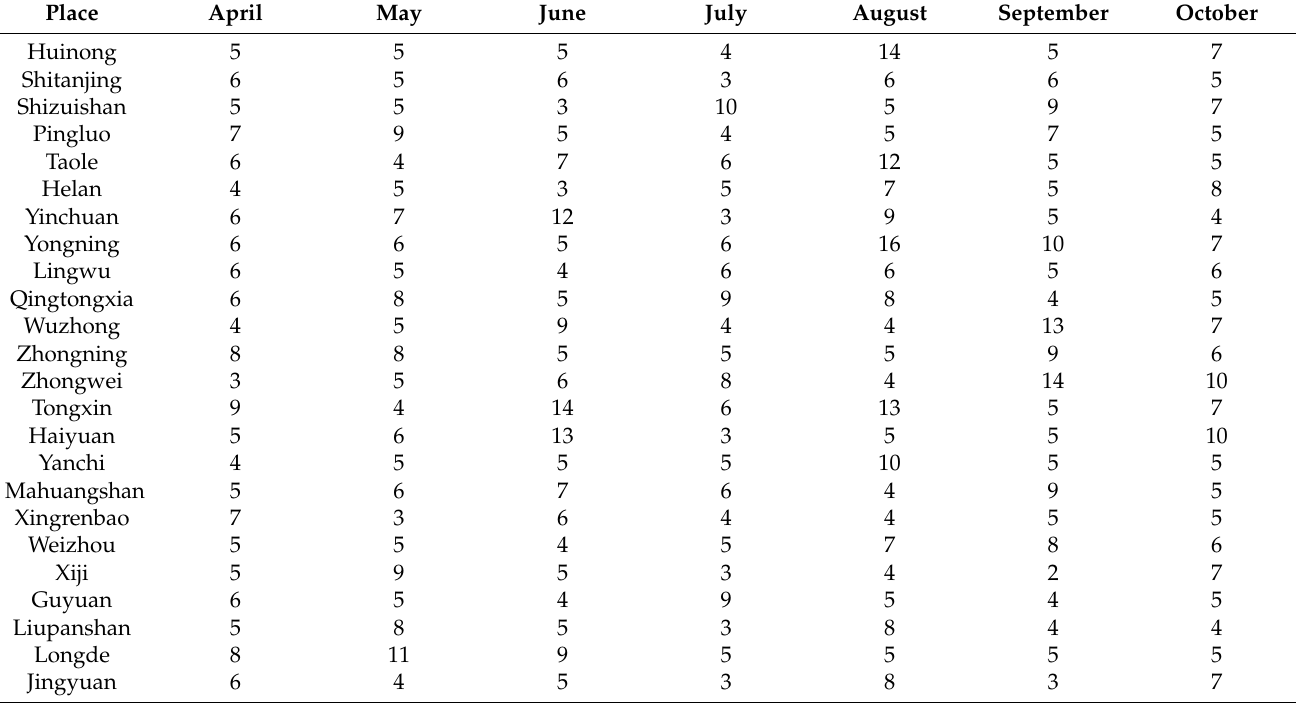
Table 4. Stepwise asymptotic regression to select the number of factors (VIF <